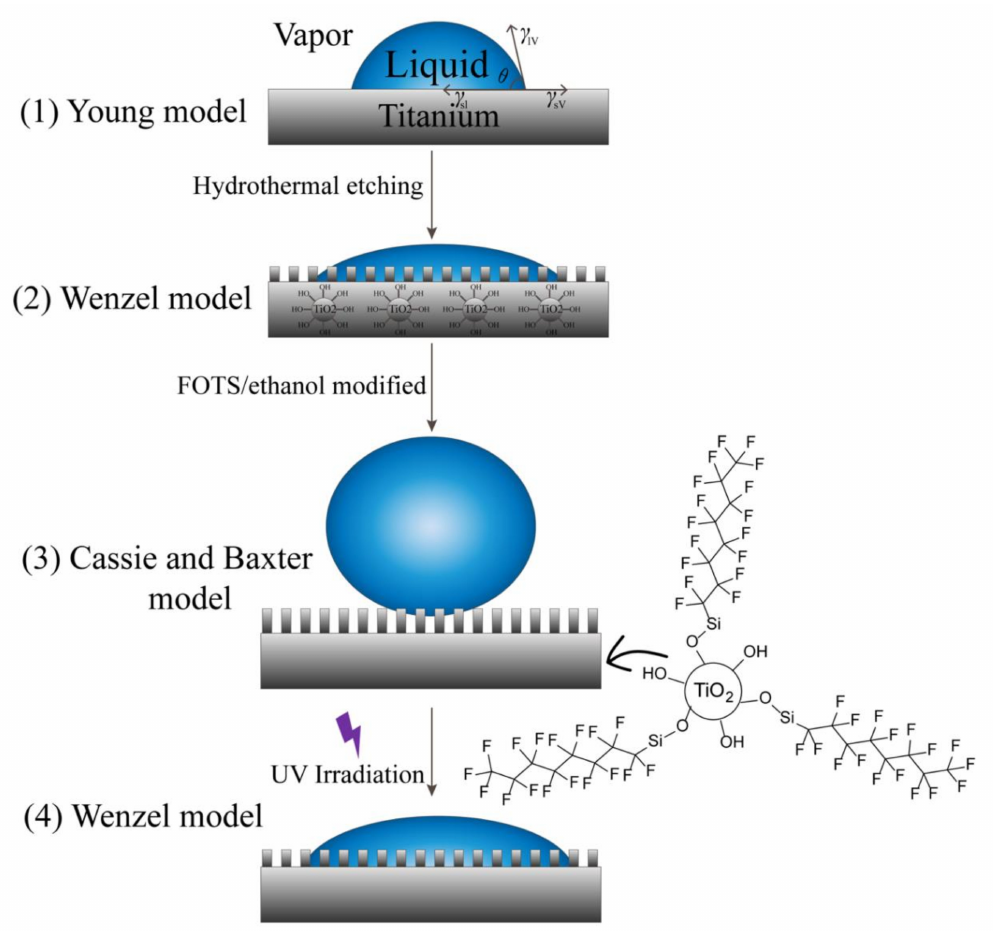
Figure 4. Model representation of the surface wettability for the preparation of Ti wires and meshes. The resulting Ti meshes with 3 typical surface states: ( 1 ) Young Model, ( 2 , 4 ) Wenzel Model, and ( 3 ) Cassie and Baxter